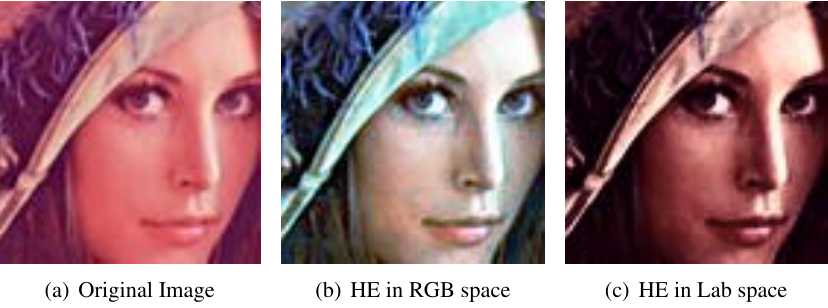
Fig. 5 Comparation between HE applied over RGB channels separately and over L channel in Lab space.